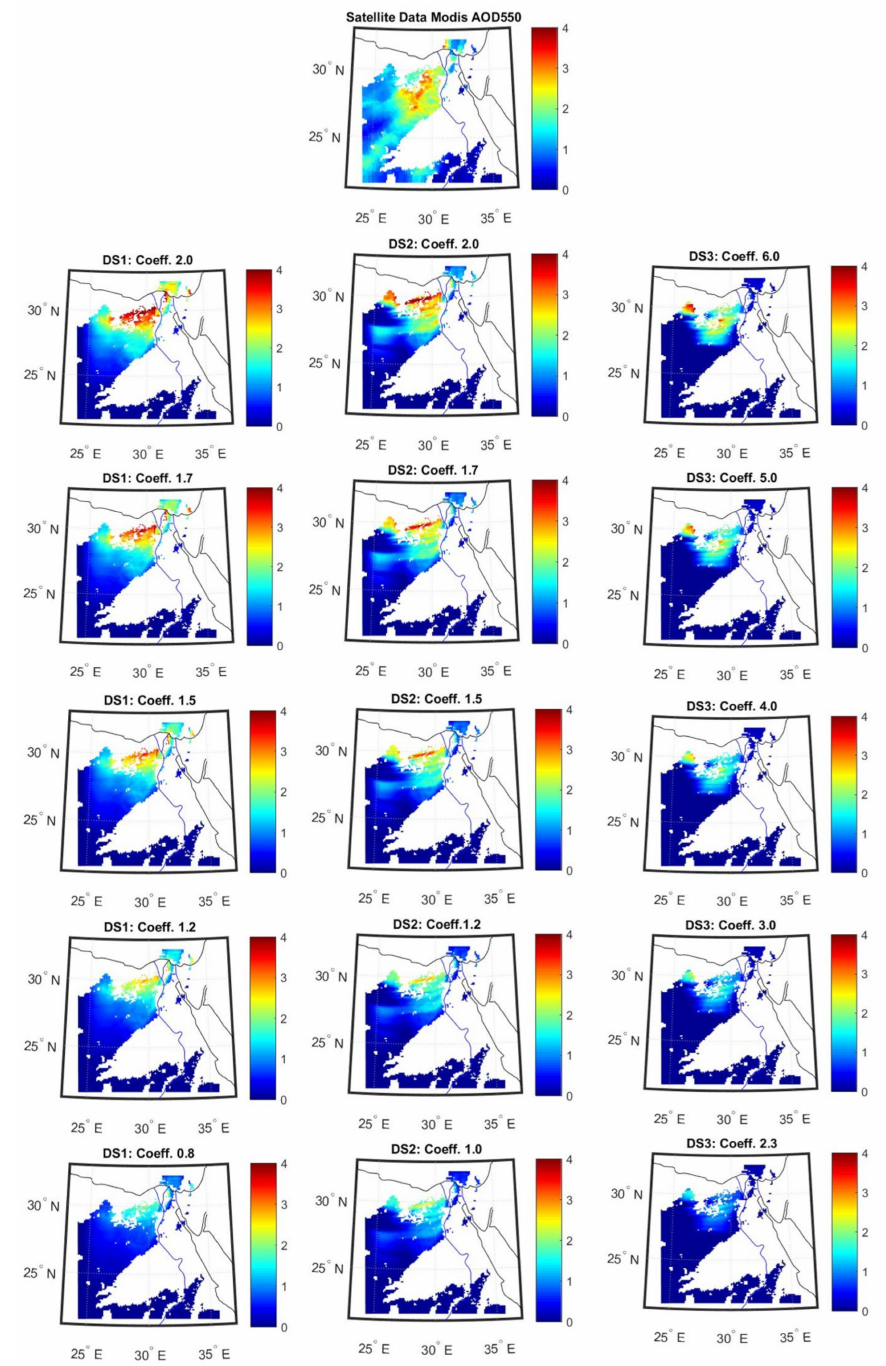
Figure 5. Spatial distribution of AOD over Egypt from MODIS (top middle) and the fifteen simulations from the model at 11:00 am (local time) for the dust event of January 2004. The color bar applies to all panels. The missing pixels in MODIS data (white areas) are excluded in the model